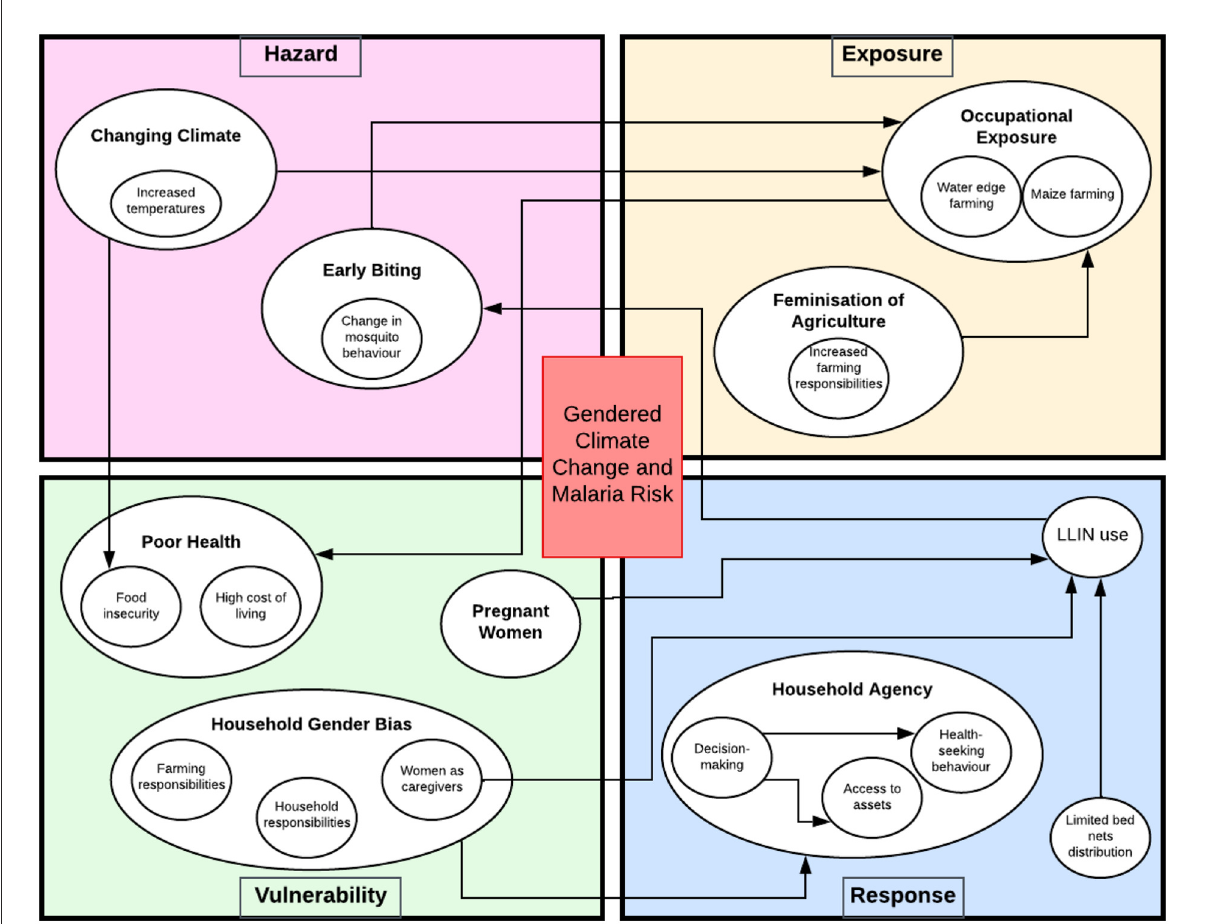
FIGURE2 Conceptual framework outlining gendered aspects of exposure and vulnerability to climate change hazards and malaria transmission, and responses to the changes in exposure and vulnerability. This framework is derived from the IPCC risk framework, complex risks theory and feminist political ecology to illustrate the complexity of the interactions between and within the gendered determinants of climate change and malaria